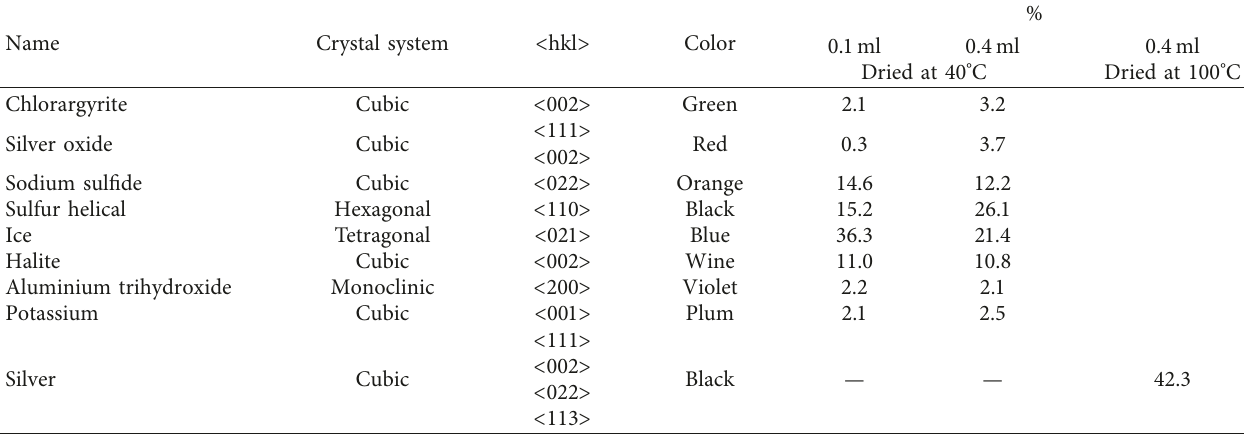
Figure 5: XRD patterns of AgNP thin films (0.1 and 0.4 ml of cochineal extract solution) dried at 40 ° C. Inset shows the schematic representation of X radiation in the thin film and the XRD pattern of AgNPs synthesized with 0.4ml of the cochineal extract (same batch) but dried at 100 ° C confirming the formation of face centre cubic silver. Table 3: Crystal structure analysis of AgNPs synthesized from 0.1 and 0.4ml of the cochineal extract dried at 40 and 100 °